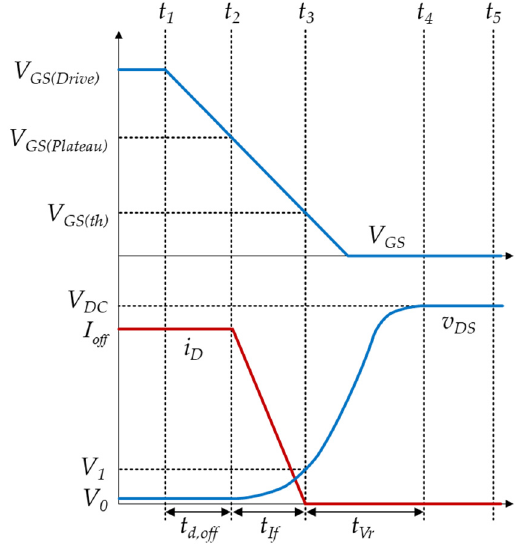
Figure 5. Switch turn-off waveform in the IH system.